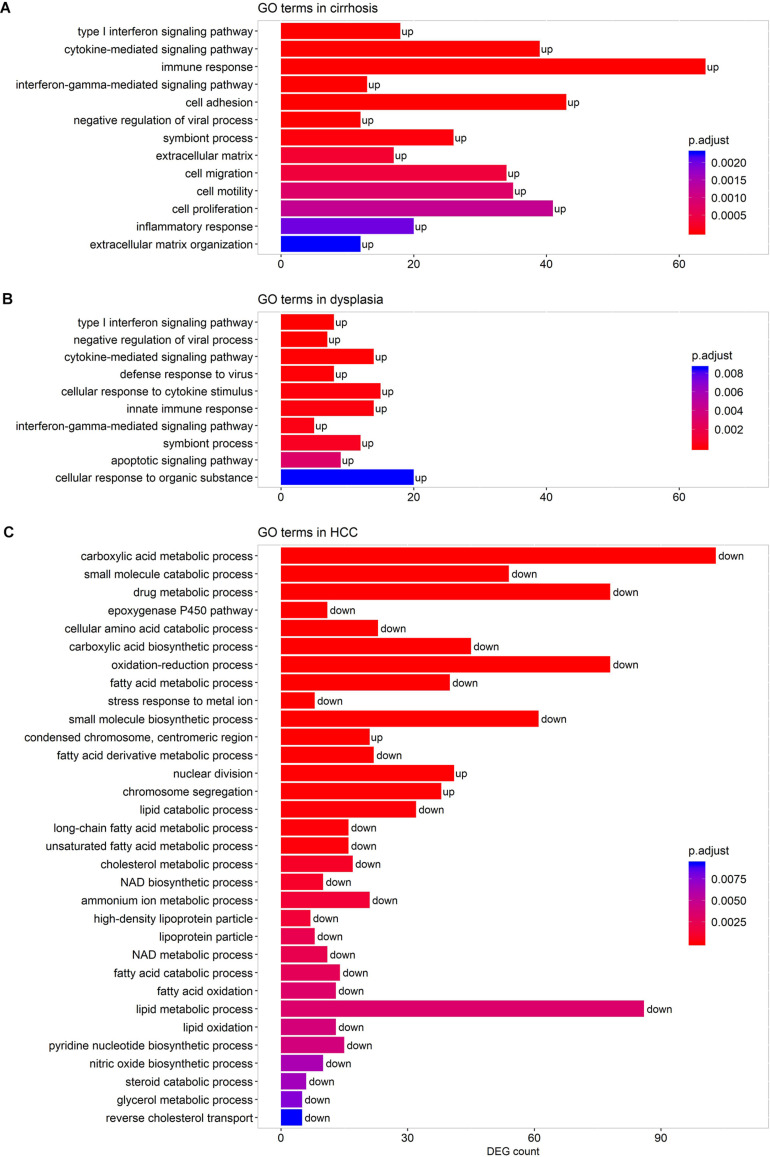
Representative GO terms enriched by the DEGs in cirrhotic (A), dysplastic (B), and HCC samples (C). A term marked as “up” indicates that it is activated, and “down” represents that it is repressed. The list of enriched GO terms is given in Supplementary Table S2.